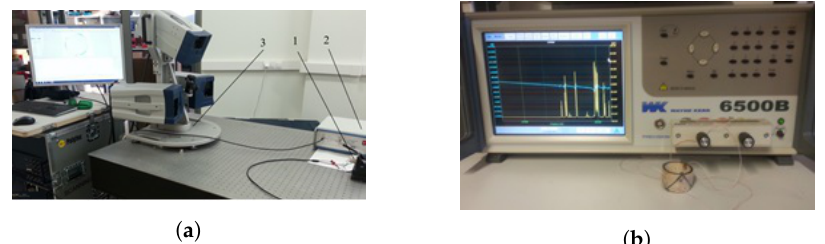
Figure 13. Experimental setup for investigating the modes of vibration ( a ) and impedance measurement of the piezoelectric cylinder ( b ): 1—piezoelectric cylinder; 2—linear amplifier; 3—3D scanning vibrometer; 4—impedance analyzer.